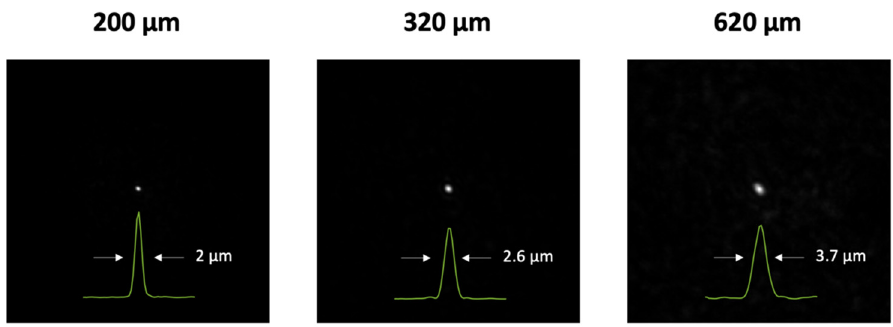
Figure 4. Light foci at various distances from the optical fibre tip.